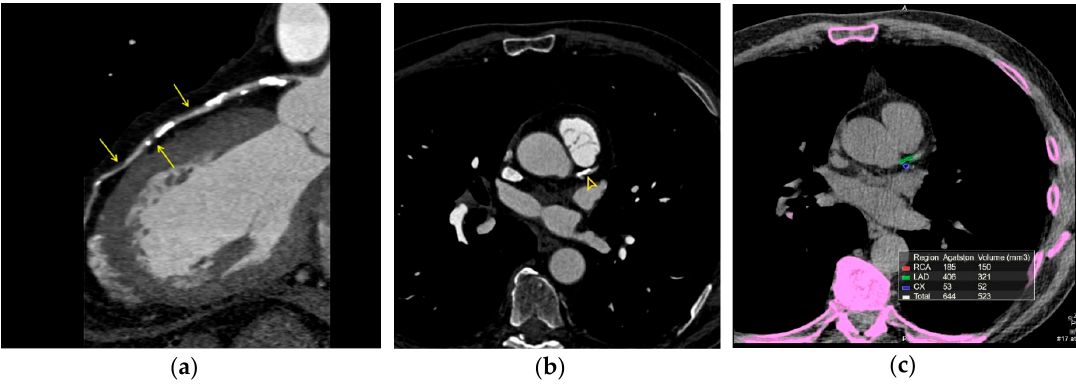
Figure 1. ( a ). Coronary computed tomography angiography. 79-year-old hypertensive patient demonstrating extensive calcified plaques of left anterior descending (LAD) coronary artery. Lipid-rich (low CT attenuation) plaques are also shown (arrows). ( b ). Same patient. Axial view. The calcific plaque involves the origin of the LAD coronary artery (yellow arrowhead). ( c ). Same patient. Agatston CAC score > 400, indicating extensive calcification, high CV risk and high likelihood of significant coronary stenosis.